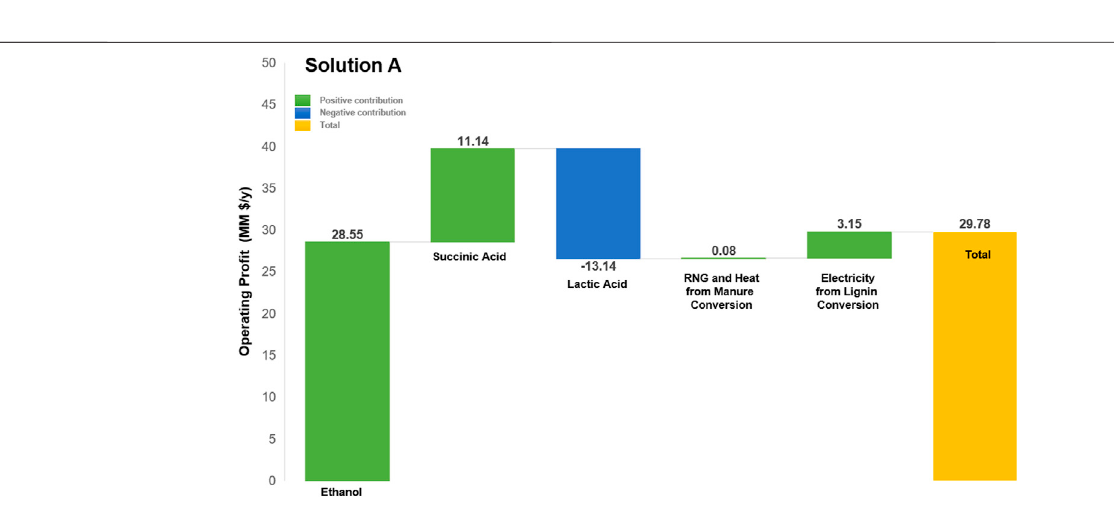
Frontiers in Chemical Engineering |